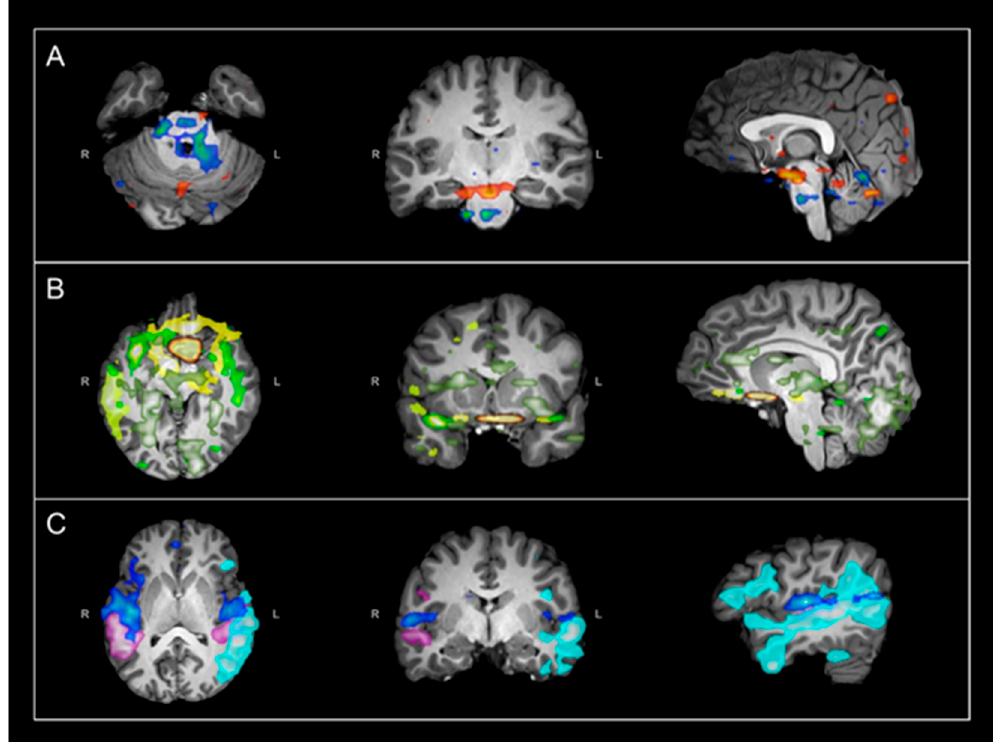
Figure 1. Select rs-fMRI networks in 16-year-old patient with ASD (case study). All images are in radiological orientation. The indicated networks are overlaid on T1-weighted images in axial, coronal, and sagittal views. ( A ) Evidence of atypical and strongly deactivated subcortical and brainstem networks in similar anatomic spatial distribution as the monoaminergic networks; ( B ) Additional atypical networks extending over multiple bilateral regions including vmPFC, FP, temporal, and occipital regions; ( C ) Normal language networks with bilateral presence of typical connectivity between receptive and expressive regions. Row A, blue color denotes BOLD deactivation, red color denotes BOLD activation. Rows B and C, each color denotes a separate network. Abbreviations: rs-fMRI = resting state functional magnetic imaging; vmPFC = ventromedial prefrontal cortex; FP = fronto-parietal.